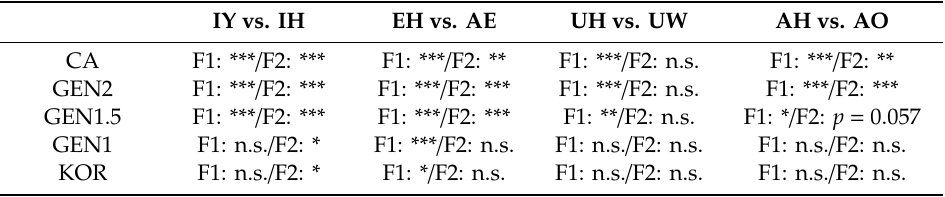
Table 2. Summary of the statistical results of English vowel contrasts.